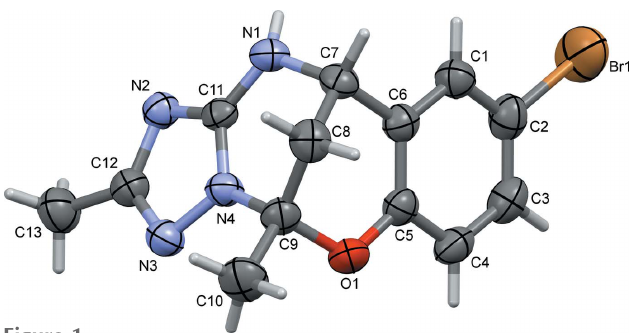
Figure 1 The molecular structure of compound I , with the atom labelling. Displacement ellipsoids are drawn at the 50% probability level.